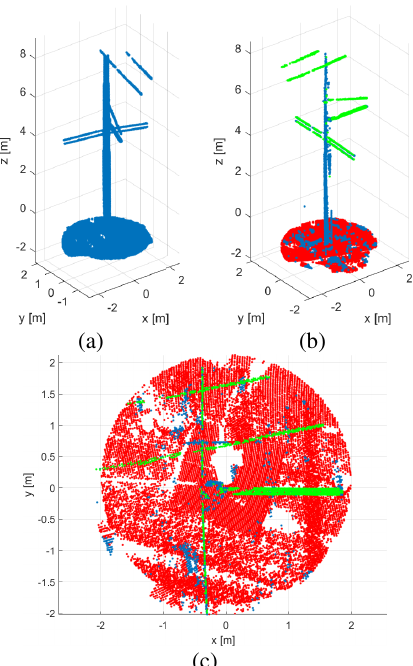
Figure 5. Example of point cloud pre-processing: (a) original data, (b) segmentation side view, mast (blue), cantilever and wires (green), ground (red), (c) segmentation re-oriented top